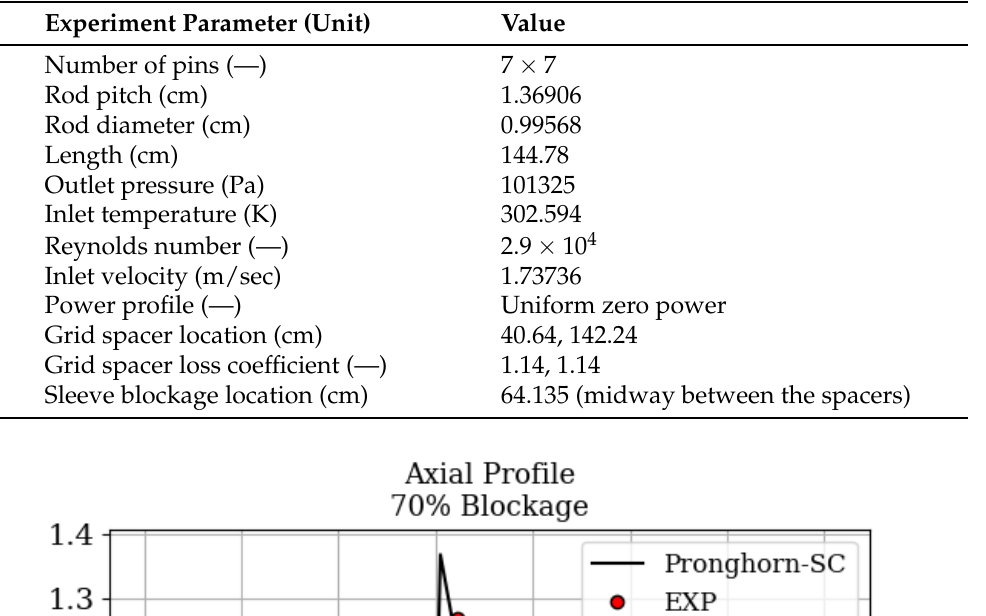
Table 7. Design and operational parameters for PNL’s 7 × 7 sleeve blockage benchmark.